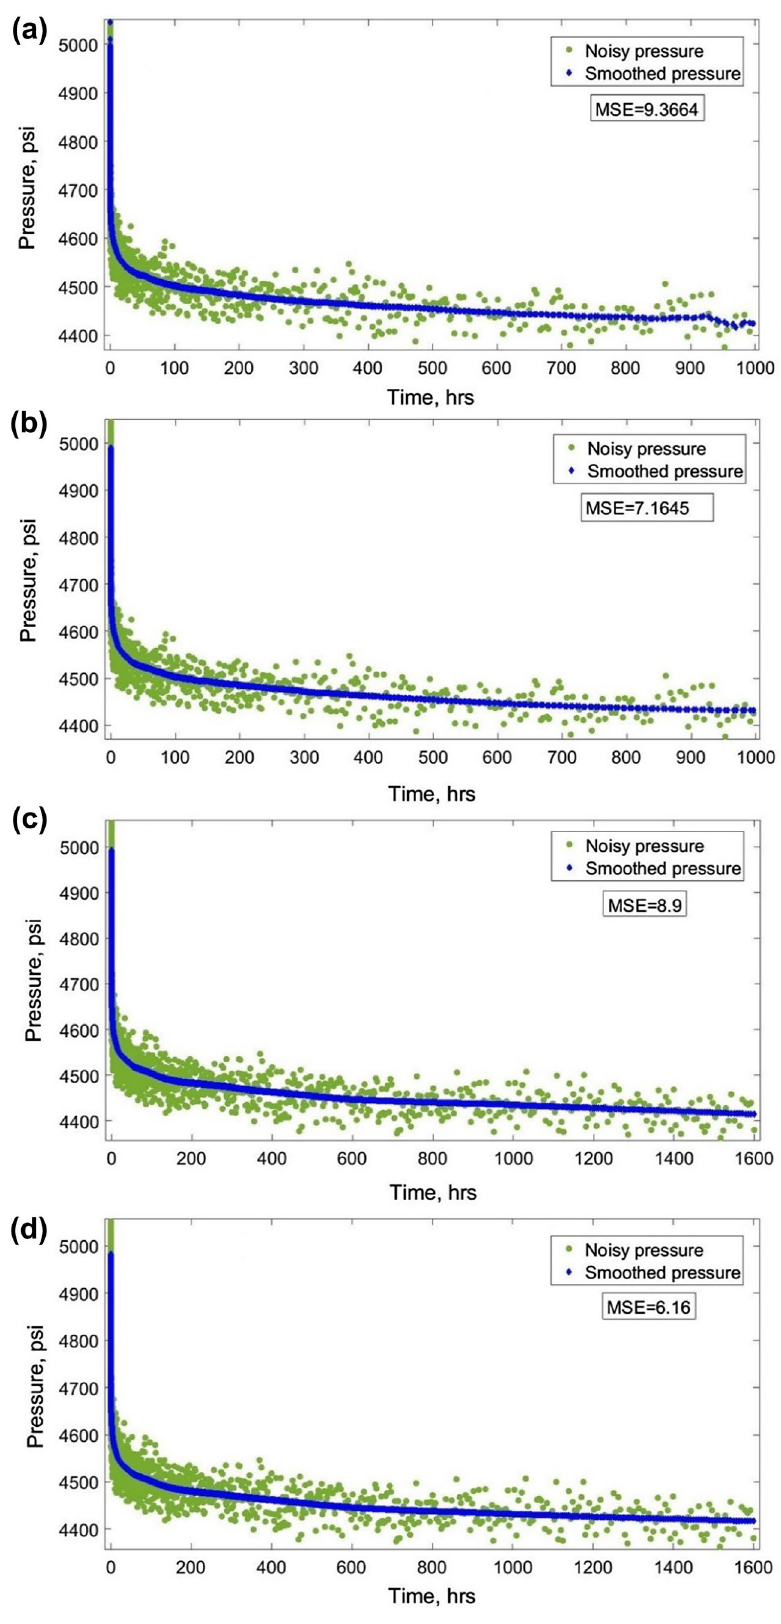
Fig. 5 Smoothed pressure data using a SMA, b S–G, c LOW- ESS, and d LOESS methods for pressure data with 2% noise